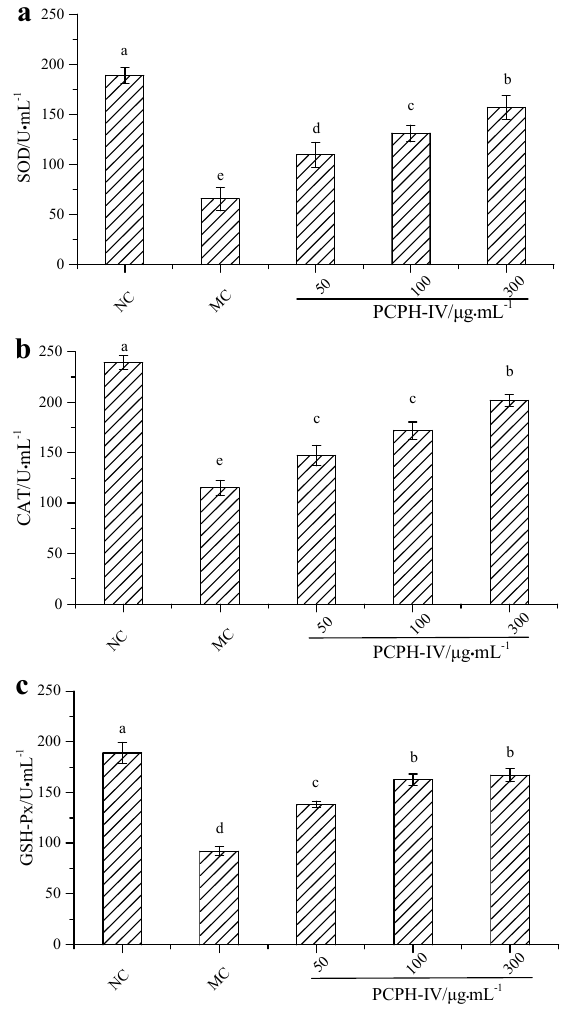
Figure 3. Effects of different concentrations of PCPH-IV on SOD ( a ); CAT ( b ); and GSH-Px ( c ) activities